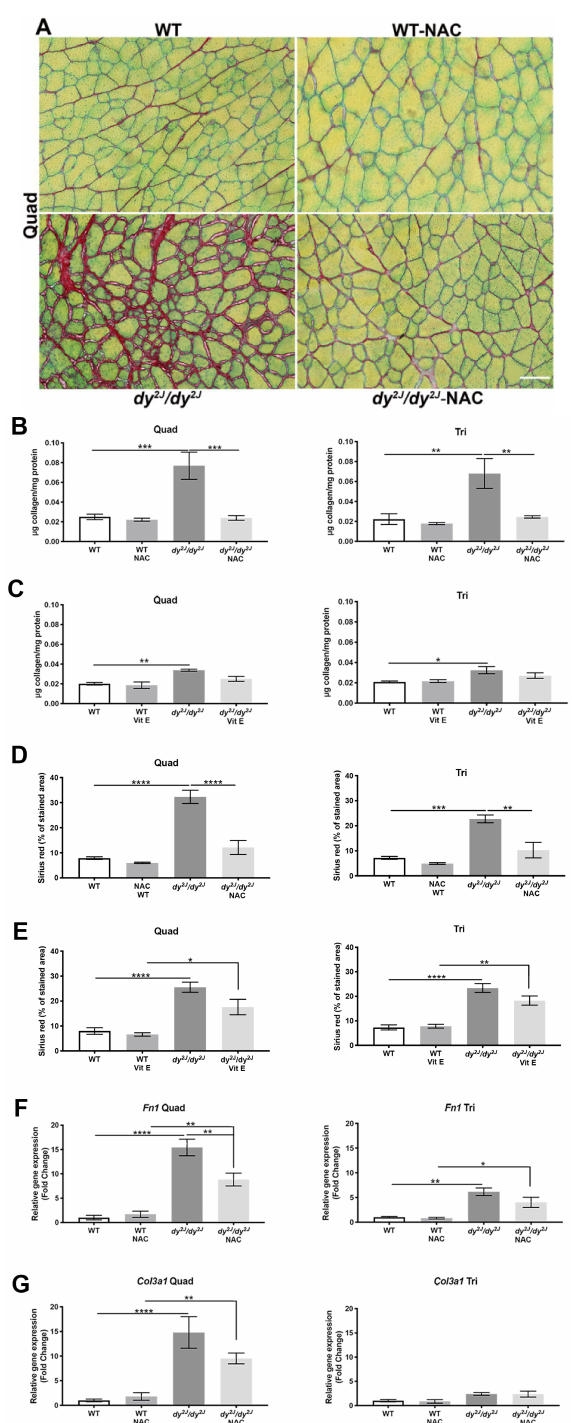
Figure 4. ( A ) Representative Fast Green and Sirius Red-stained quadriceps muscle sections. Bar: 100 µ m; ( B ) Collagen content in 6 WT, 10 WT NAC, 8 dy 2J / dy 2J , 6 dy 2J / dy 2J NAC quadriceps and 5 WT, 10 WT NAC, 7 dy 2J / dy 2J , 6 dy 2J / dy 2J NAC triceps muscles; ( C ) Collagen content in 5 WT, 6 WT vit E, 5 dy 2J / dy 2J , 5 dy 2J / dy 2J vit E quadriceps and triceps muscles. Quantitative analysis of collagen content (fibrosis area) in ( D ) 4 WT, 5 WT NAC, 5 dy 2J / dy 2J , 4 dy 2J / dy 2J NAC quadriceps and 4 WT, 4 WT NAC, 3 dy 2J / dy 2J , 3 dy 2J / dy 2J NAC triceps muscles and ( E ) 5 WT, 4 WT vit E, 5 dy 2J / dy 2J , 4 dy 2J / dy 2J vit E quadriceps and 4 WT, 4 WT vit E, 4 dy 2J / dy 2J , 3 dy 2J / dy 2J vit E triceps muscles; ( F , G ) qPCR analysis of genes related to fibrotic tissue build-up; ( F ) Expression of Fn1 encoding fibronectin in quadriceps and triceps muscles; ( G ) Expression of Col3a1 encoding the α 1-chain of collagen III in quadriceps and triceps muscles. Results are expressed as mean ± SEM and are expressed as fold change of WT in 5 WT, 5 WT NAC, 4 dy 2J / dy 2J and 6 dy 2J / dy 2J NAC. * p < 0.05, ** p < 0.01, *** p < 0.001 and **** p <